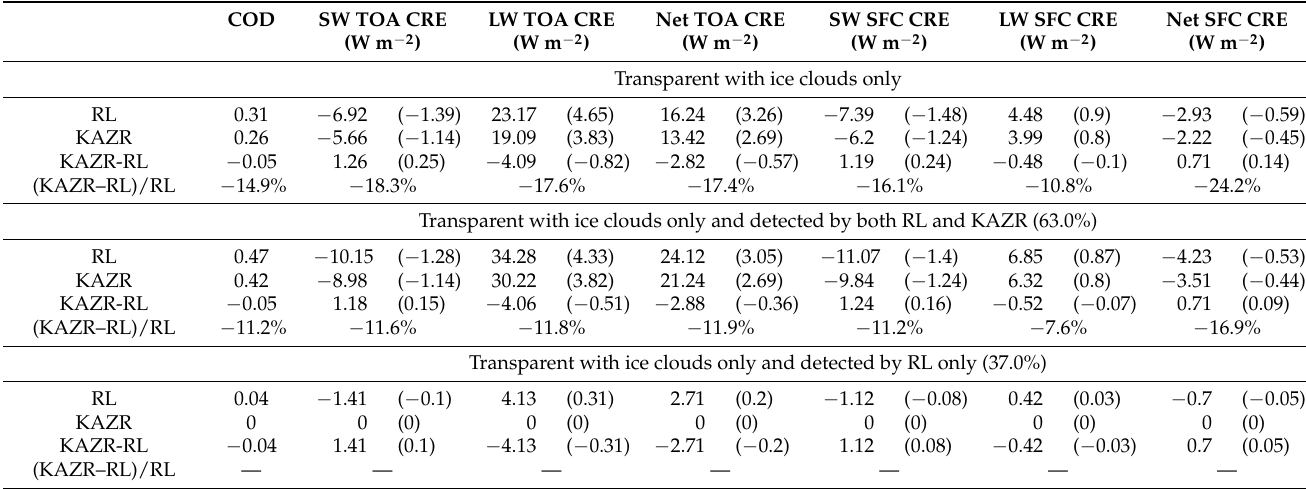
Table 2. Same as Table 1, but for the Raman lidar (RL) and Ka-band ARM Zenith Radar (KAZR) observations at the Southern Great Plains (SGP) site from January 2011 to December